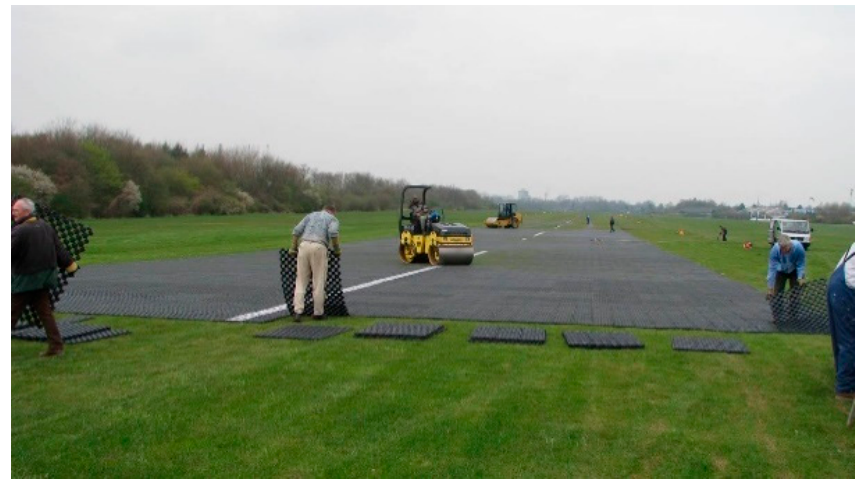
Figure 2. Solution made by the company Novus HM.